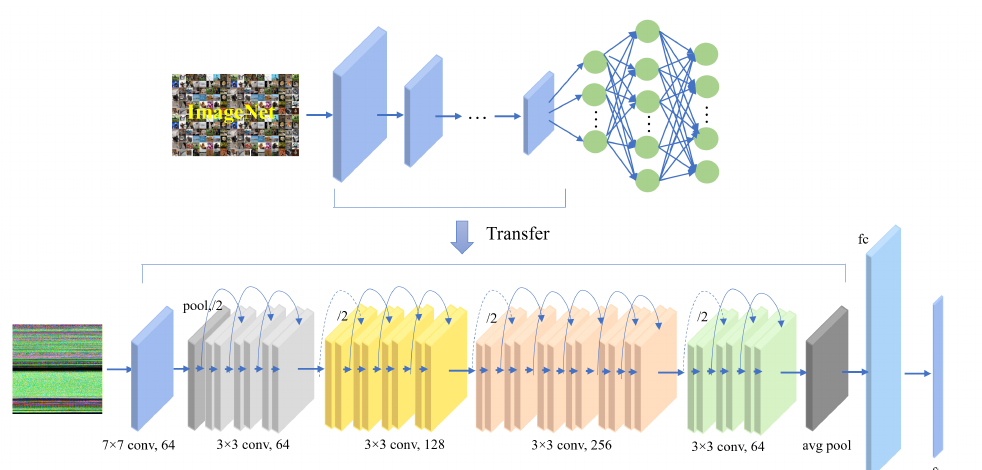
Figure 5. Proposed neural network